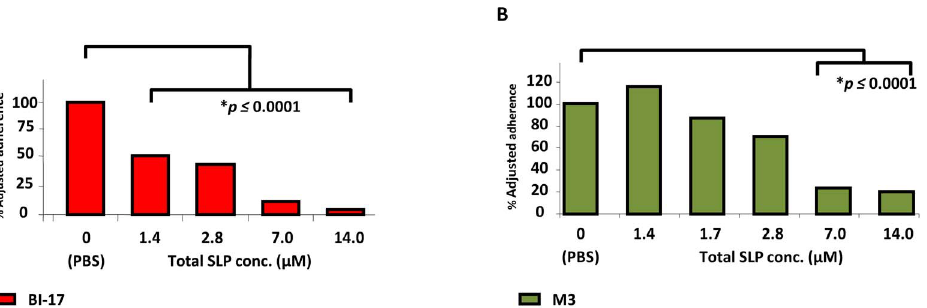
Figure 6. C.difficile adherence is inhibited by pre-coating host cells with surface layer protein preparations. Total SLP protein from strain BI-17 (toxigenic) or strain M3 (non-toxigenic) were overlaid on C2 BBE monolayers, and followed by adherence assays for the cognate C. difficile vegetative bacteria. For comparative purposes, data were converted to percent adjusted adherence, with adherence of the control (no added SLP) set to 100%; therefore, no error bars are shown. Asterisks indicate significant differences ( p # 0.01). Epidemic-associated, ribotype 027 strains are shown as red bars, and non-toxigenic strains are shown as green bars.